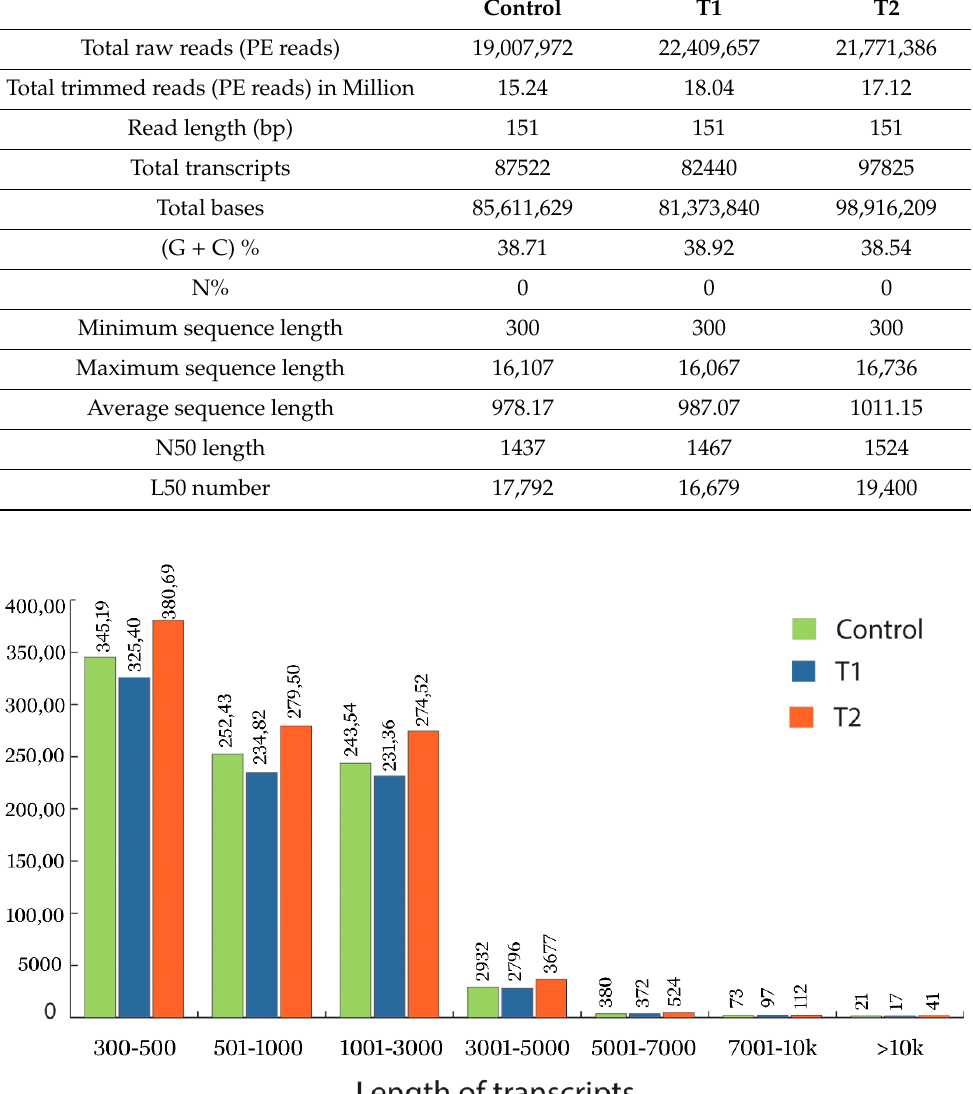
Table 1. H. persicum transcriptome assembly statistics for the control sample, T1 (48 h PEG treatment) sample and T2 (72 h PEG treatment) sample.